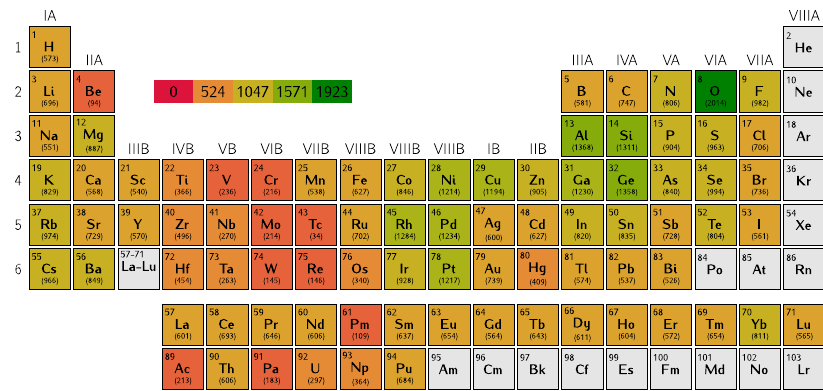
Fig. 2 Distribution of stable materials. The number of stable materials containing a given element through the periodic